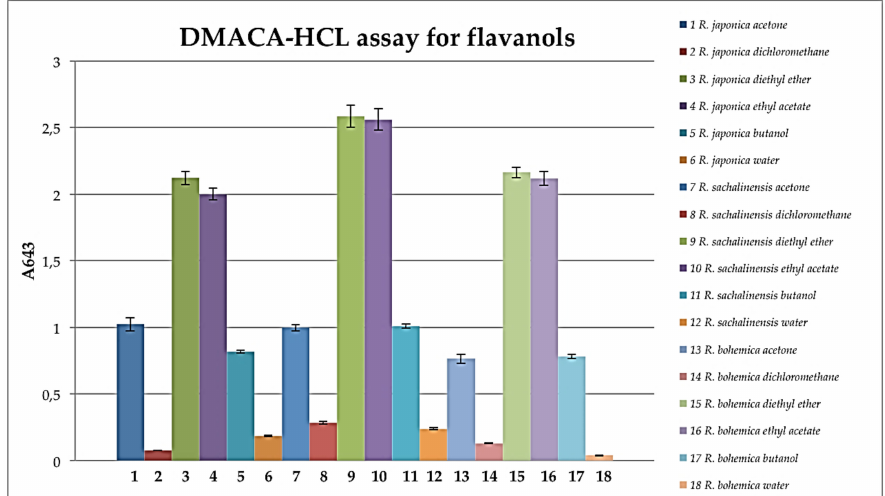
Figure 9. Flavanols quantified spectrophotometrically for absorbance at 643 nm in extracts and fractions. Data were expressed as mean ± SD, performed in at least three independent experiments, assayed in